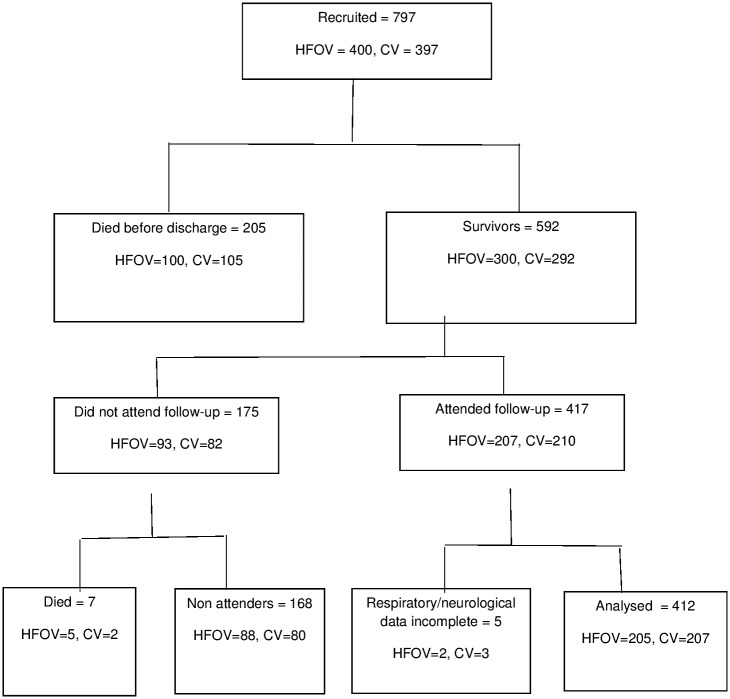
Study flow chart.